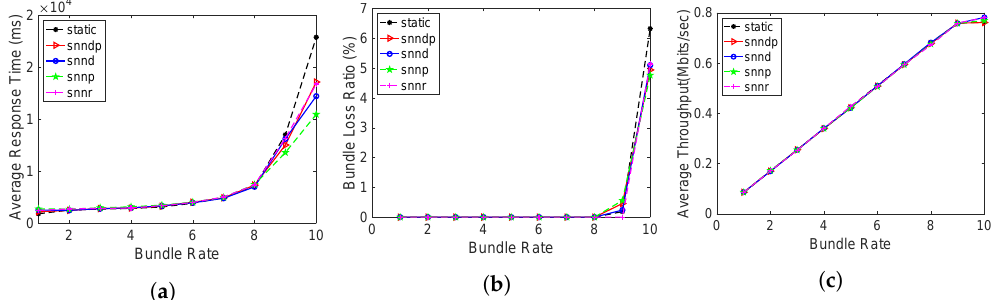
Figure 9. Routing performance: Scenario 4. ( a ) Average response time; ( b ) Packet loss ratio (%); ( c )